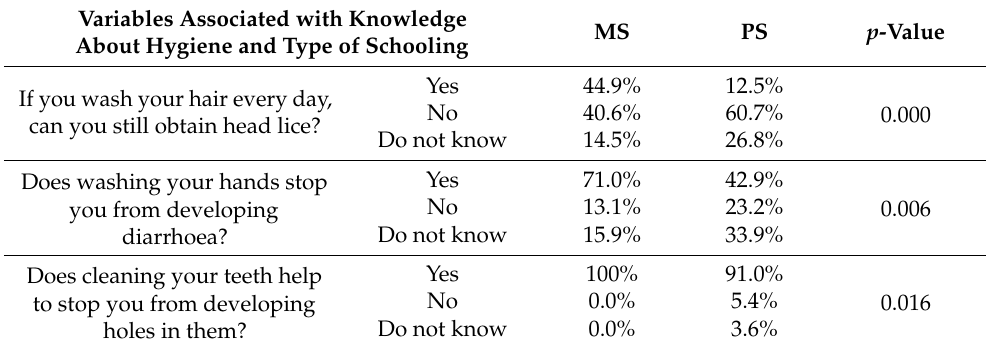
Table 3. Association between knowledge of hygiene and type of schooling.